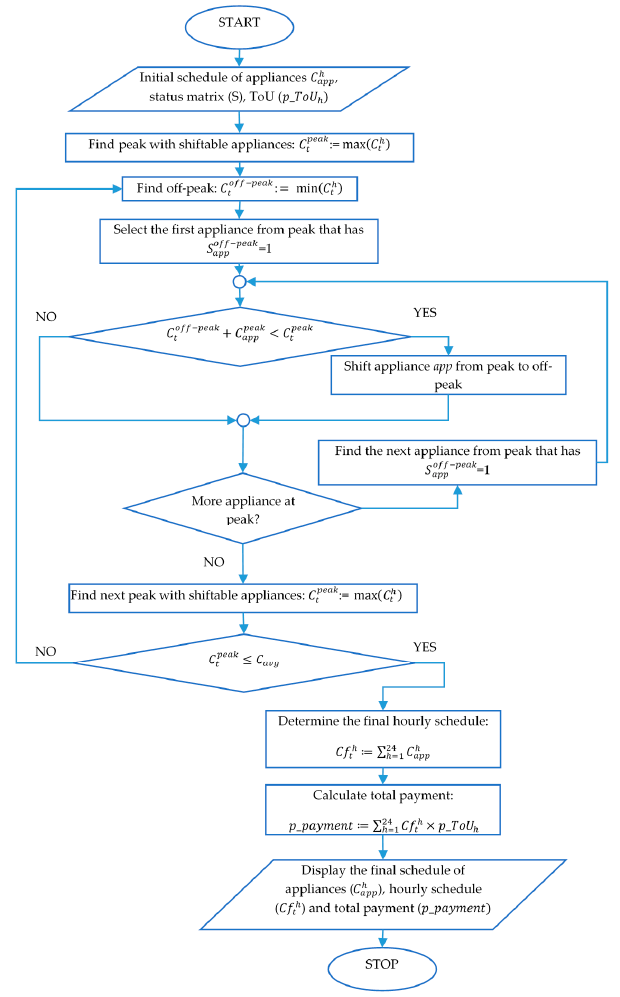
Figure 7. Flowchart of the shifting Algorithm 3.